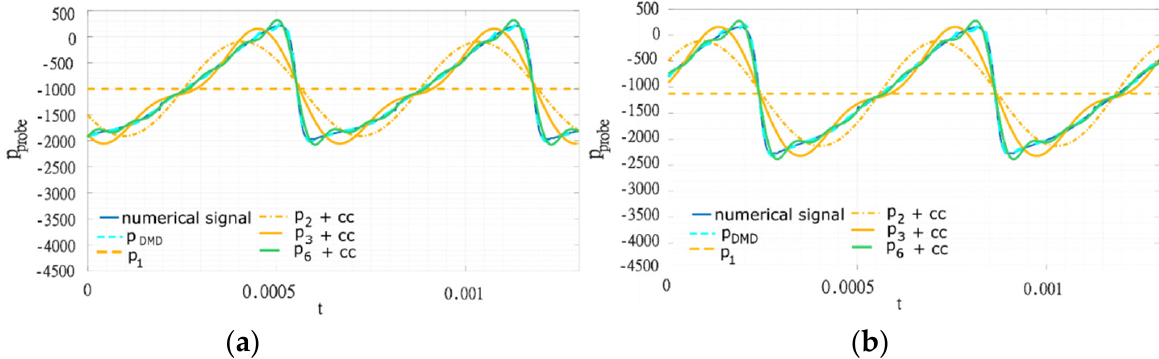
Figure 6. Partial DMD reconstruction; p 1 : least-squares fit, p i + cc: DMD modes plus complex conjugate (cc) up to i th order; ( a ) 13 modes 4.85 kg/s without grid, ( b ) 13 modes 4.85 kg/s with 60° grid.